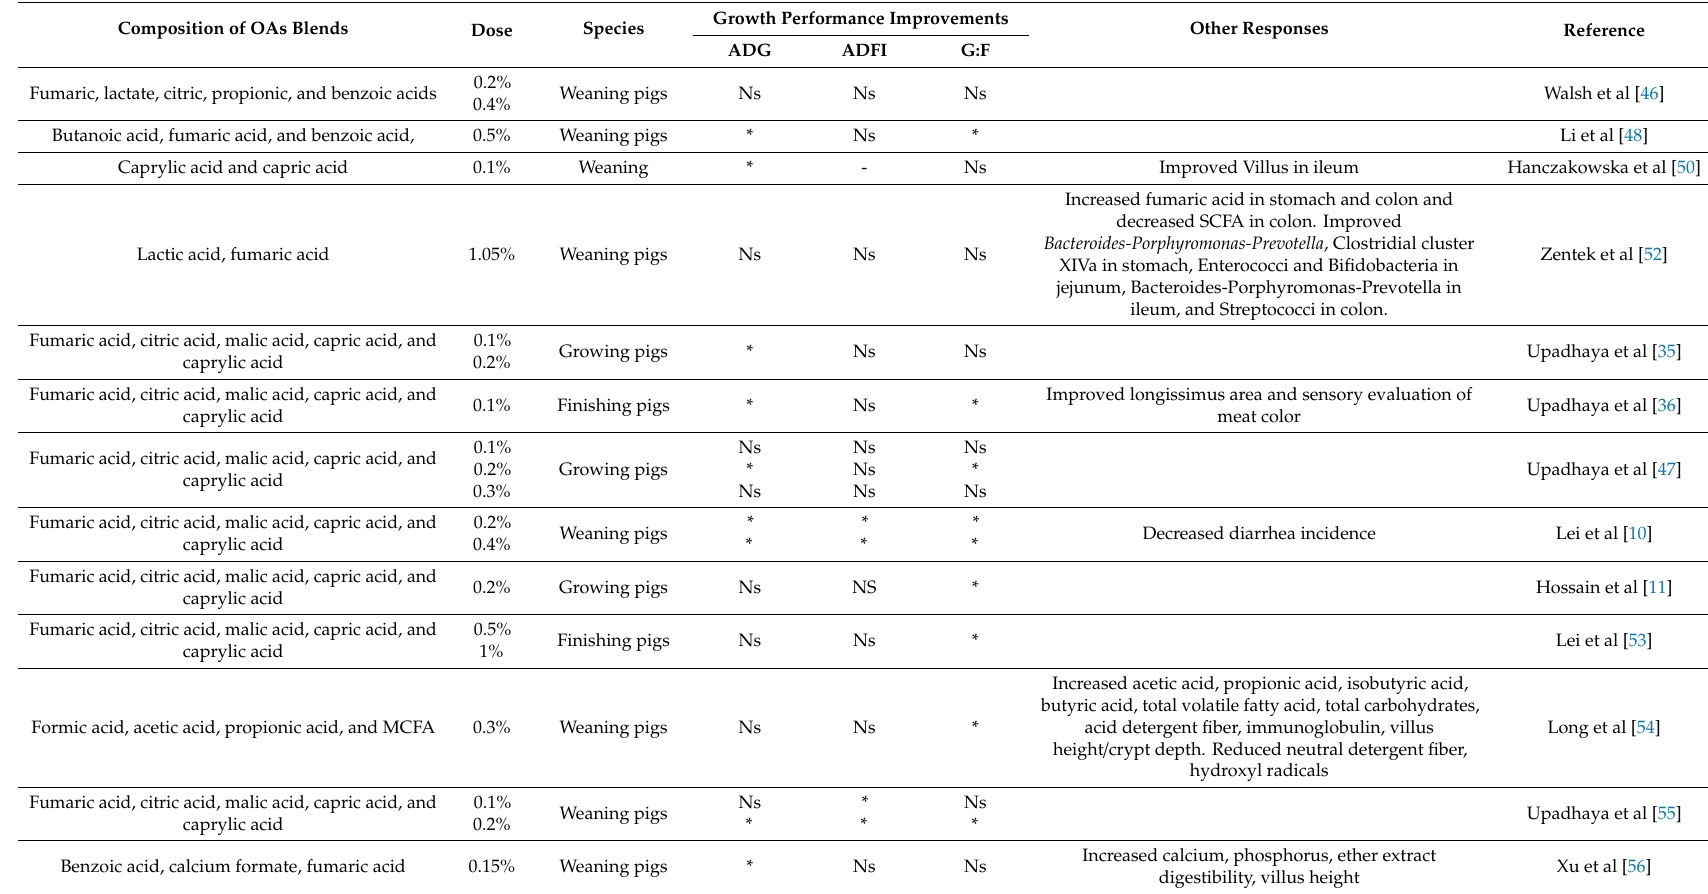
Table 2. Response of organic acid (OA) mixtures on growth performance and other parameters in